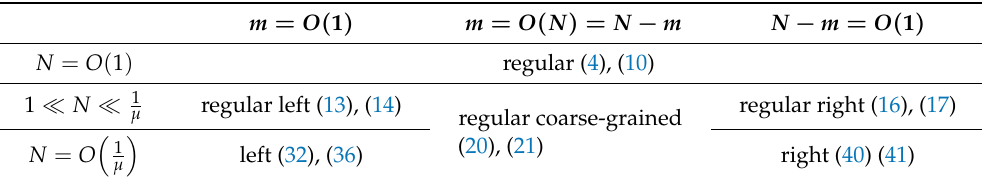
Table 1. Overview of approximate solutions to Equation (1) and their regions of validity within definition domain 0 ≤ m ≤ N < ∞ . The first reference indicates a formula that applies for a mixed initial population; the second reference indicates an exclusively sensitive initial population. The linked formulae contain population transition Rates (23) and the (partial summations of the) Lea–Coulson probability mass function